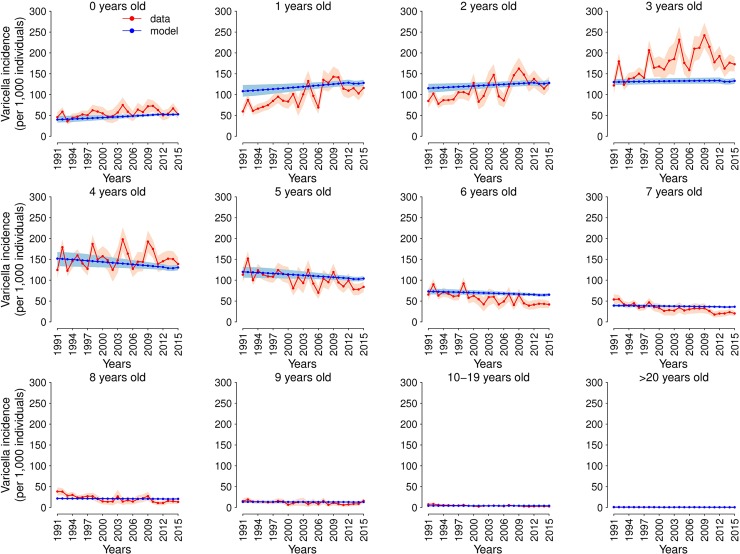
Incidence of varicella by age (1991–2015).Incidence of varicella by age as observed in France between 1991 and 2015 (red) and as estimated by model M2 (blue). Shaded areas show the 95% CI of data and of model estimates.